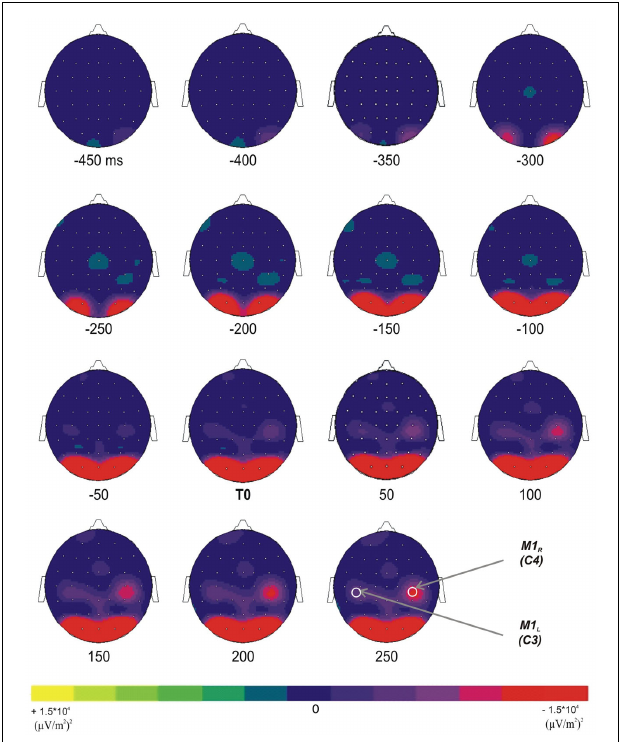
FIGURE 3 |Topographic representations (top view) of theTF energy time course (from − 450ms beforeT0 to + 250 afterT0, with a 50-ms step) in the 10- to 13-Hz frequency range; grand average across subjects. Two distinct diminutions occurred over the occipital and the superior central areas.